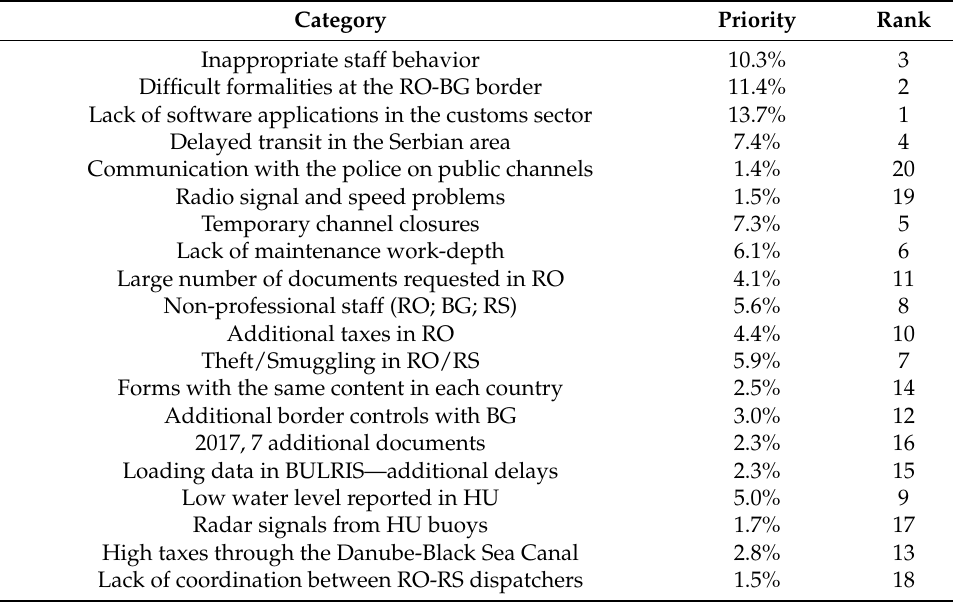
Table 2. Priority ranking of the